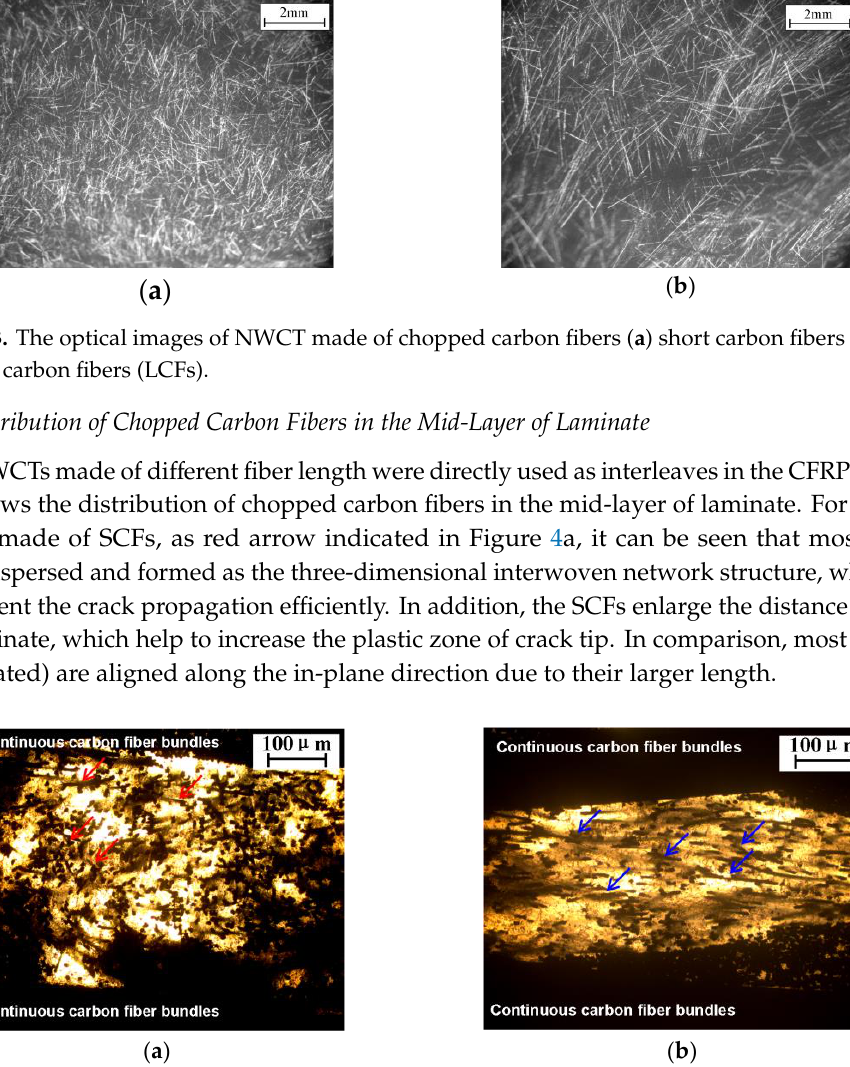
Figure 4. The optical images of the mid-layer of laminates interleaved with NWCTs made of ( a ) SCFs; ( b ) LCFs . ( b )